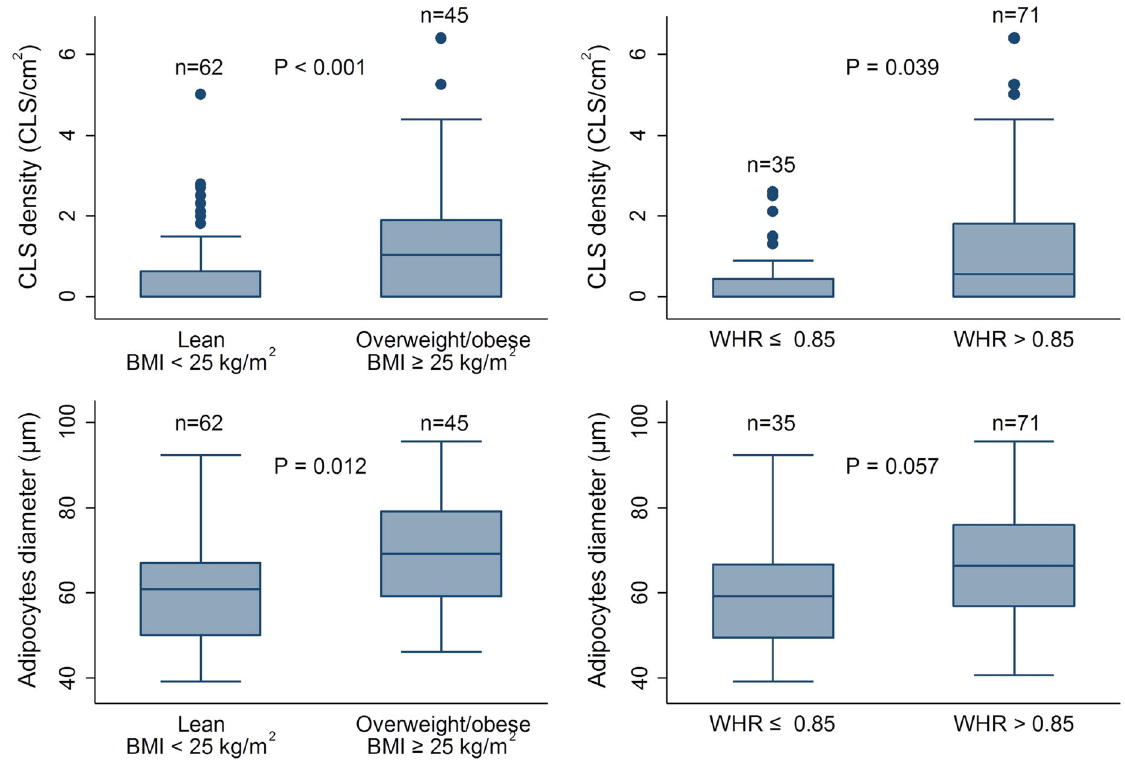
Fig. 2 Distribution of CLS density ( top panel ) or adipocyte diameter ( bottom panel ), strati fi ed in lean vs. overweight/obese patients, as measured either by BMI ( left panel ) or WHR ( right panel ). The P -values are obtained from tests of equal